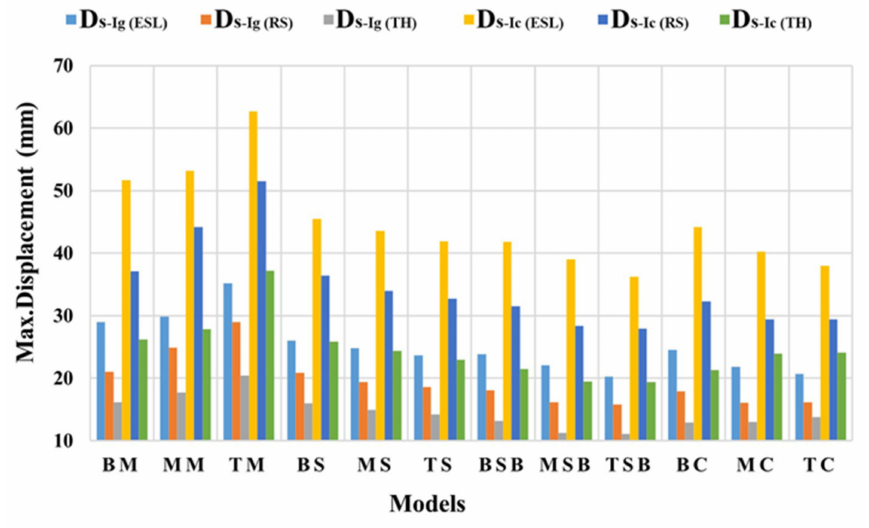
Figure 10. Maximum roof displacement for different irregularity models.